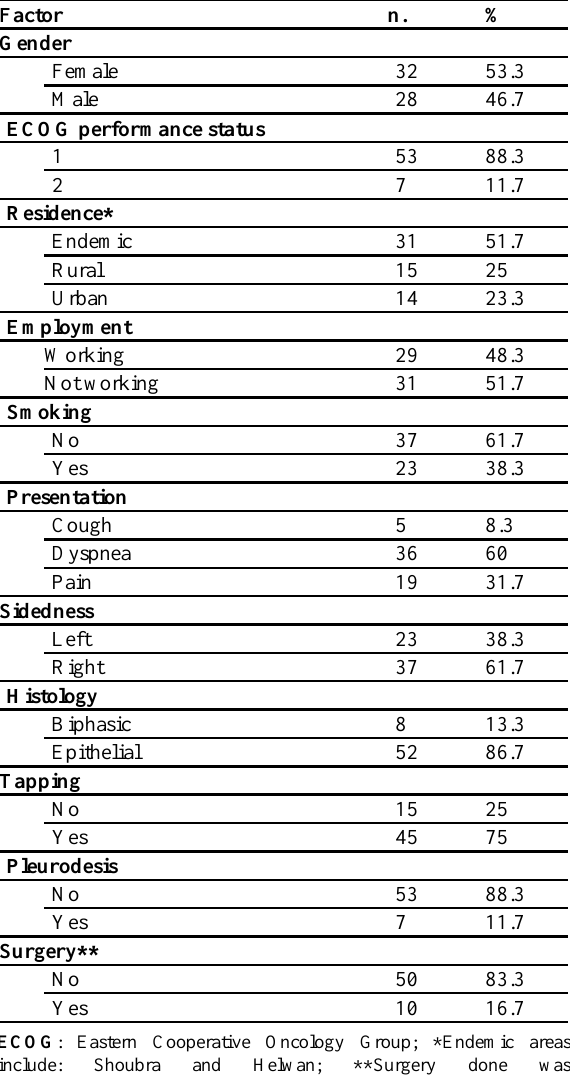
Table 1: Clinico-pathological and Epidemiological Factors